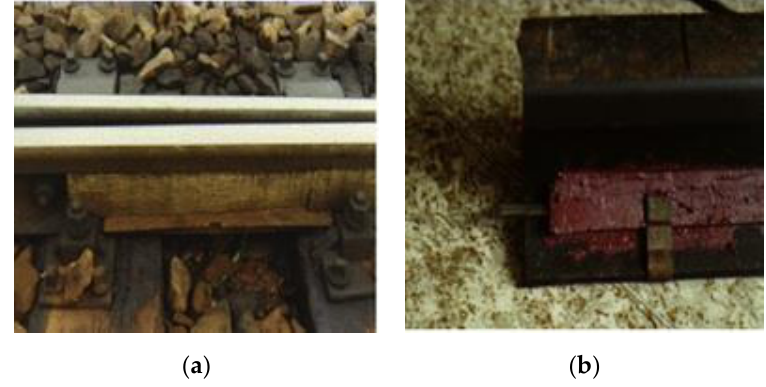
Figure 2. Examples of heat insulation mounting: ( a ) heat insulating and ( b ) heat conducting [3,4].